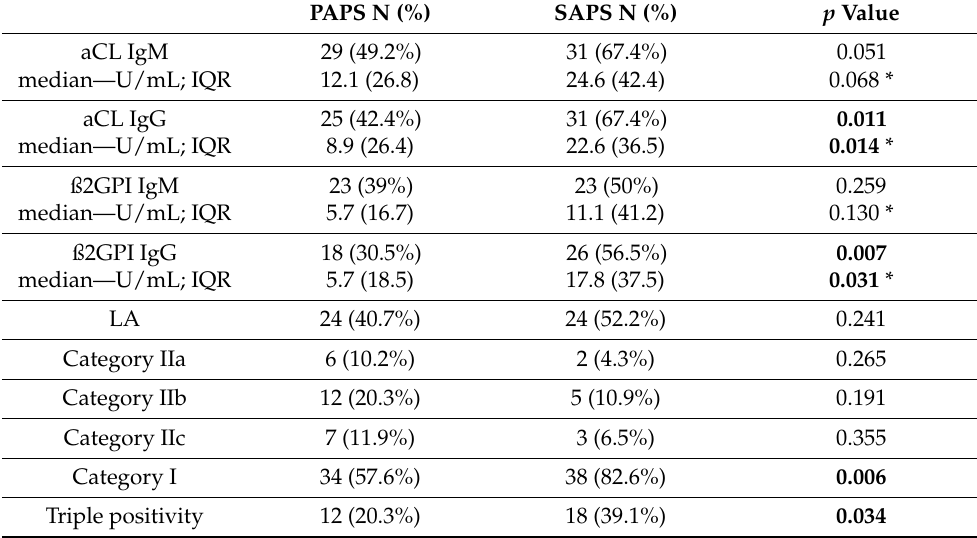
Table 2. The distribution of aPL in the PAPS and SAPS